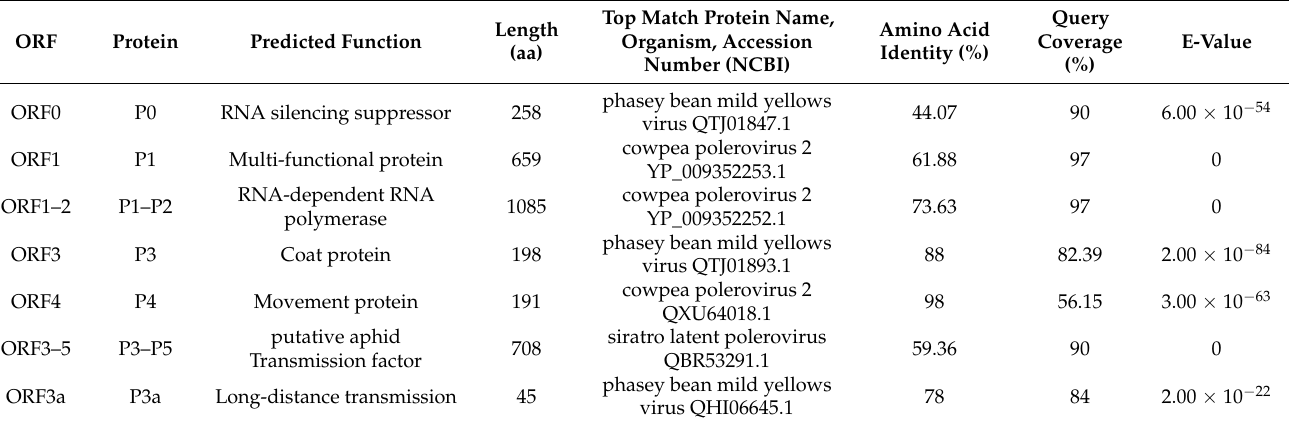
Table 1. Top match from amino acid sequence comparisons with predicted proteins from soybean chlorotic leafroll virus through blastp searches of the NCBI non-redundant protein sequence